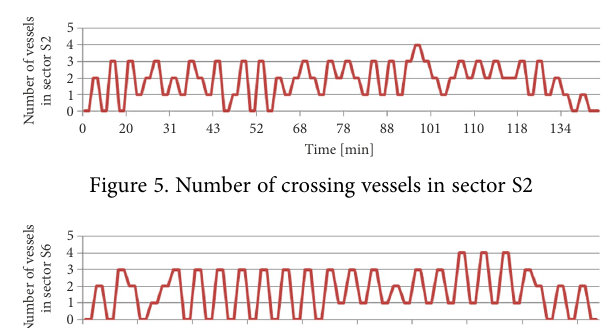
Figure 4. Number of crossing vessels in sector S3